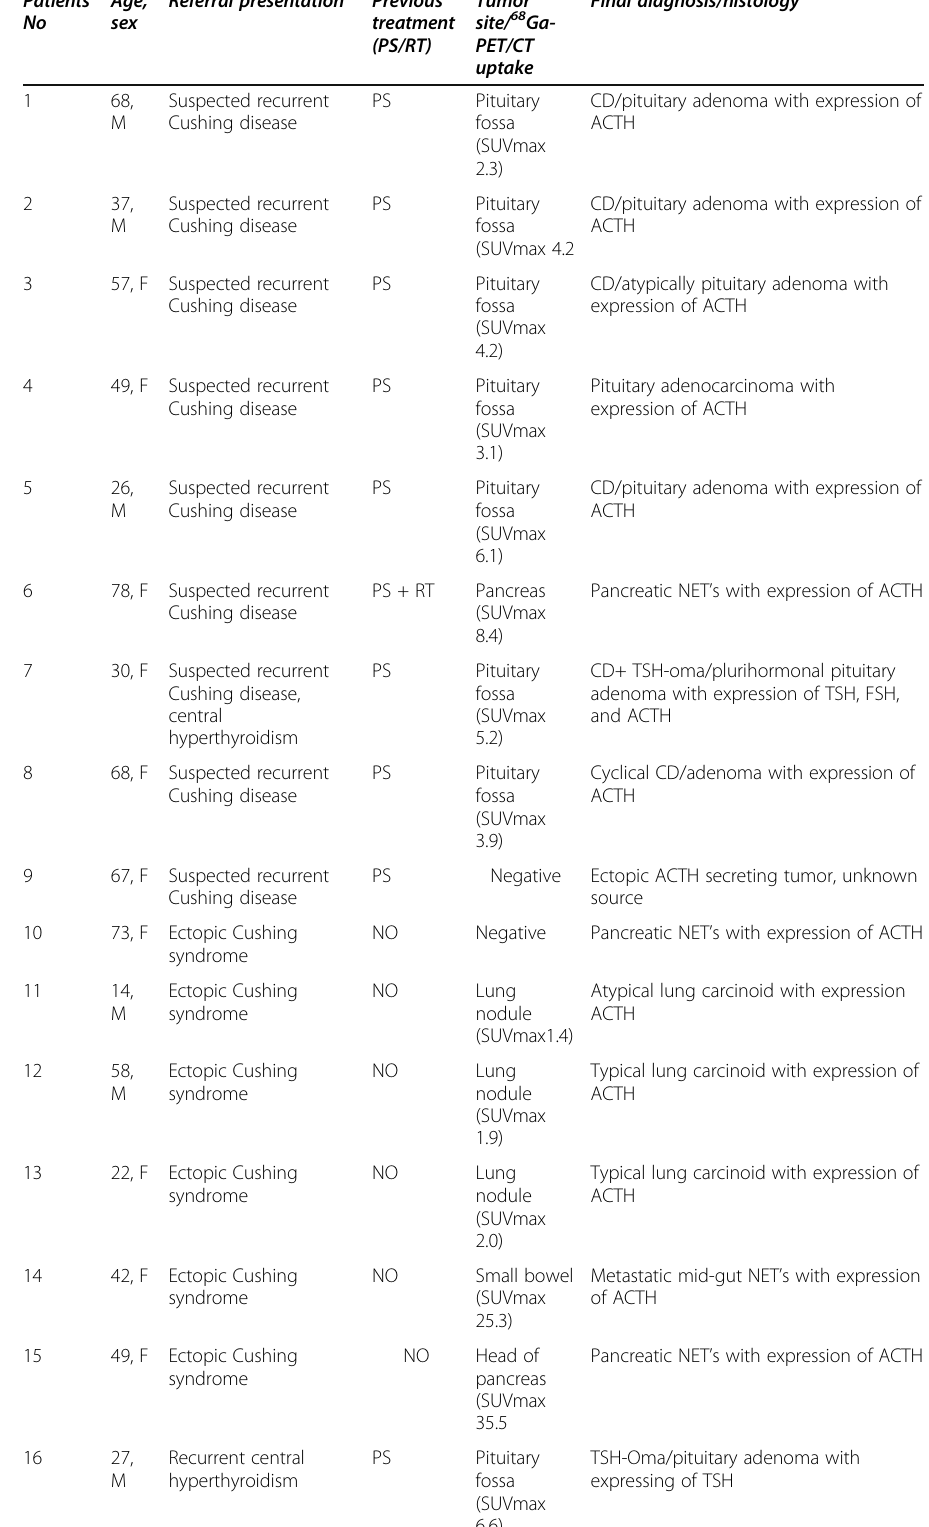
Table 2 Summary of tumor characteristic and finding Patients